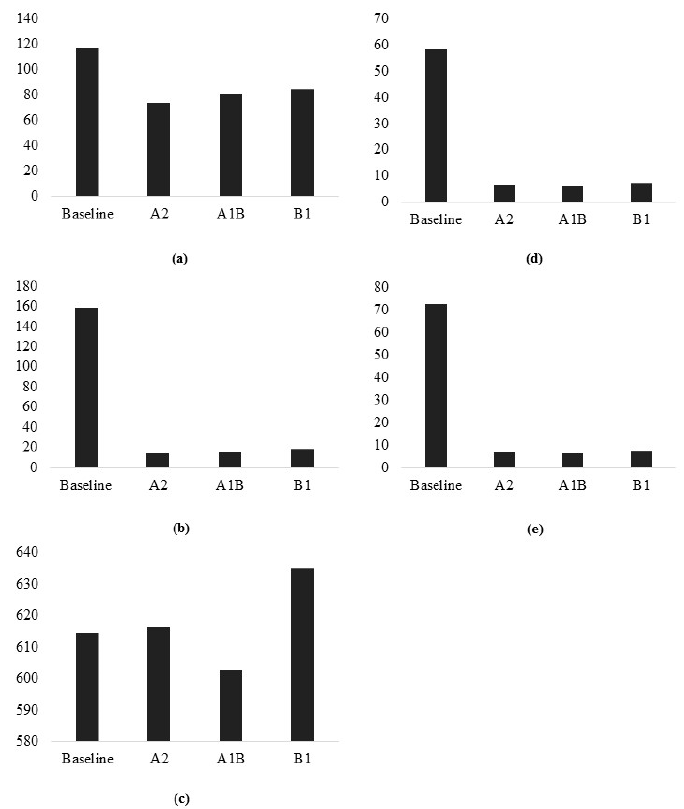
Figure 5. Variations in different hydrologic components ( a ) Snowmelt, in mm; ( b ) Soil water storage (SW), in mm; ( c ) Actual evapotranspiration (AET), in mm; ( d ) Surface runoff (SURQ), in mm; ( e ) Total water yield (WYLD), in mm on annual basis in response to projected climate change